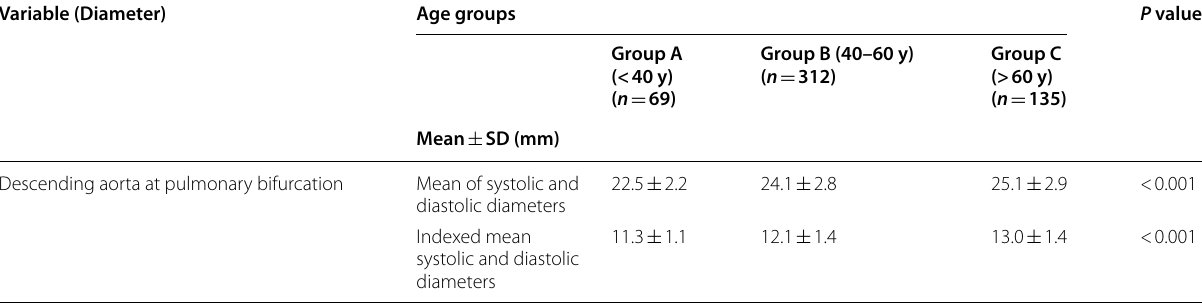
Table 12 Comparison of descending thoracic aortic diameters at pulmonary bifurcation level among different age groups Variable (Diameter) Age